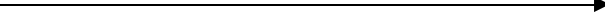
Fig. 1. Data panels indicating, from the top ( a ) CUTLASS back- scatter power, ( b ) EISCAT UHF observations of ion-line power profiles at four di(cid:128)erent heights close to the heater ‘‘matching height’’, both versus time, and ( c ) three measurements of SEE features at three di(cid:128)erent times corresponding to heater frequencies of 4.10 MHz, 4.05 MHz and 4.10 MHz from left to right respectively. The times of measurements are presented in the panels